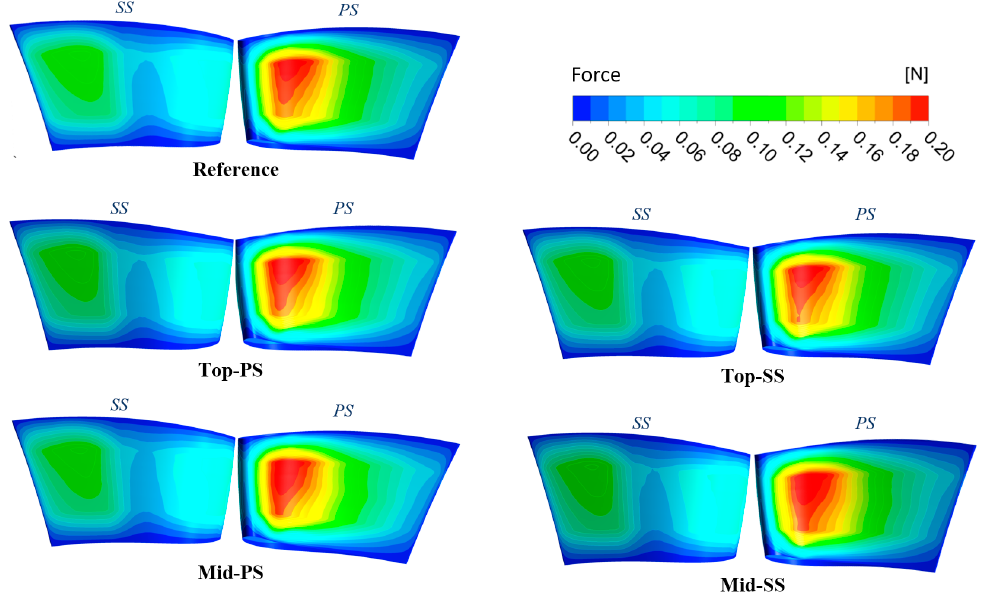
Figure 12. Force distribution on the S2 vane surface under different damaged-blade conditions.